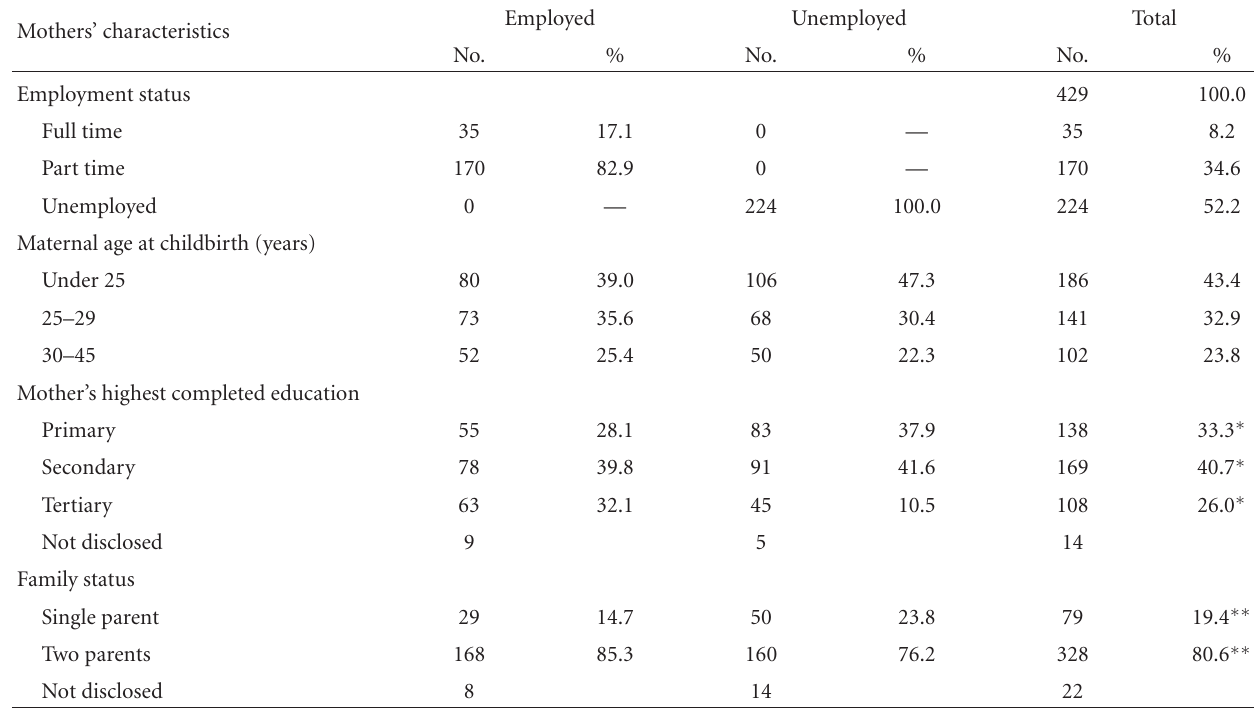
Table 1: Characteristics of mothers in the study.